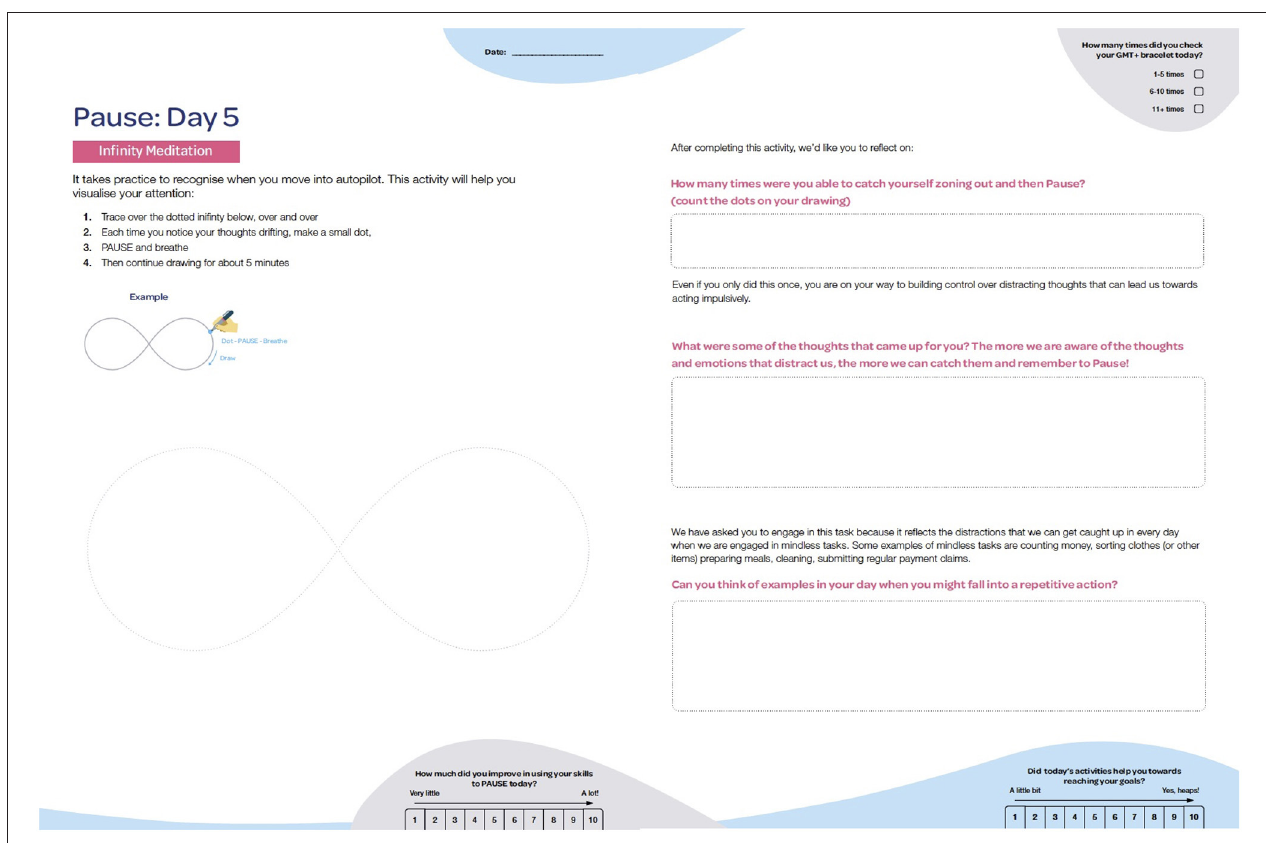
FIGURE 6 | A creative journal activity and guided questions to connect the relevance to everyday life.